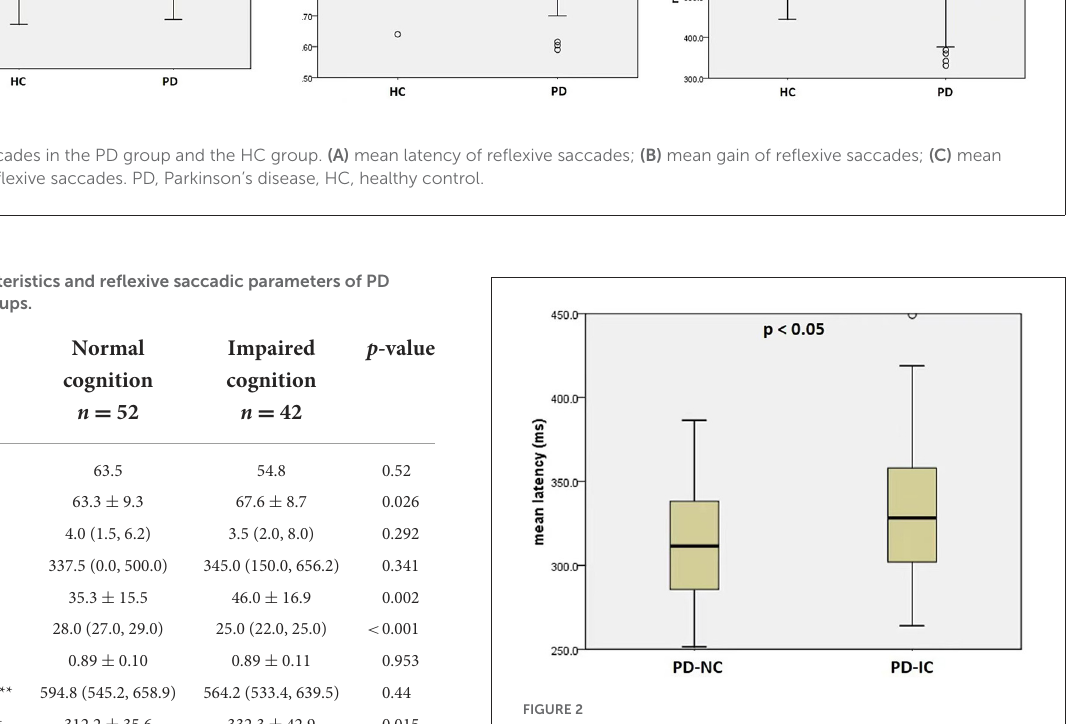
FIGURE2 Mean latency of reflexive saccades in PD patients with normal cognition (PD-NC) and PD patients with impaired cognition